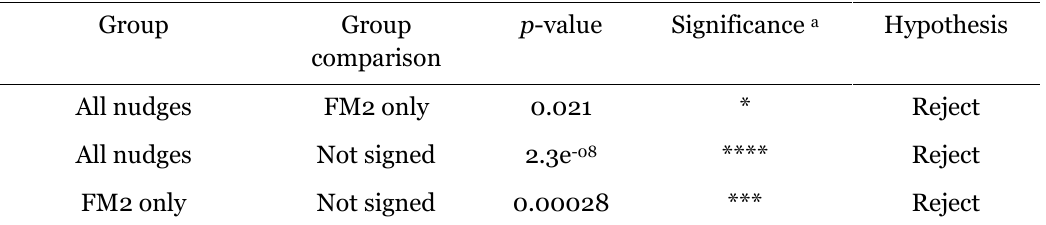
Results of the Unpaired Two-Sample Wilcoxon Test on Final Mark Distribution